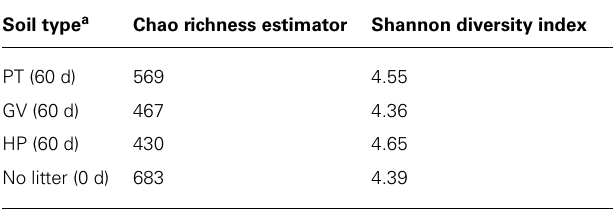
Table 5 | Diversity of bacterial communities in microcosms with soil and leaf litter from Populus tremuloides . Soil type a